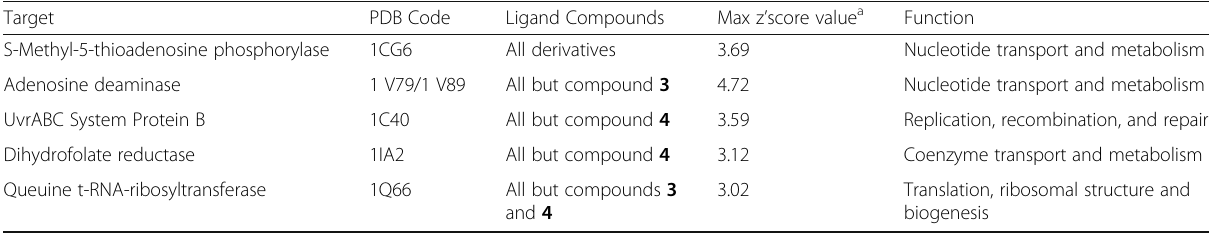
Table 3 Pharmmapper results Target PDB